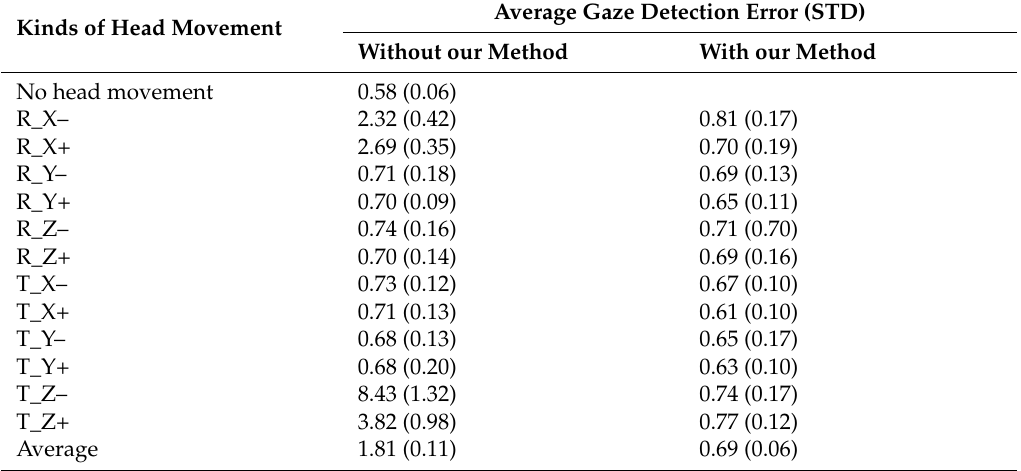
Table 3. Average gaze detection errors of ten subjects with or without our method (unit: ˝ ).